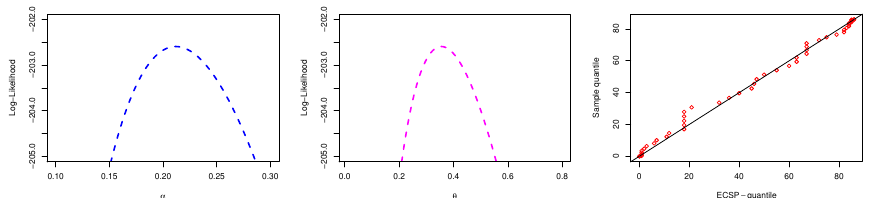
Figure 14. Plots of the profile-log likelihood functions, and the quantile–quantile plot of the ECSP model for real data I.